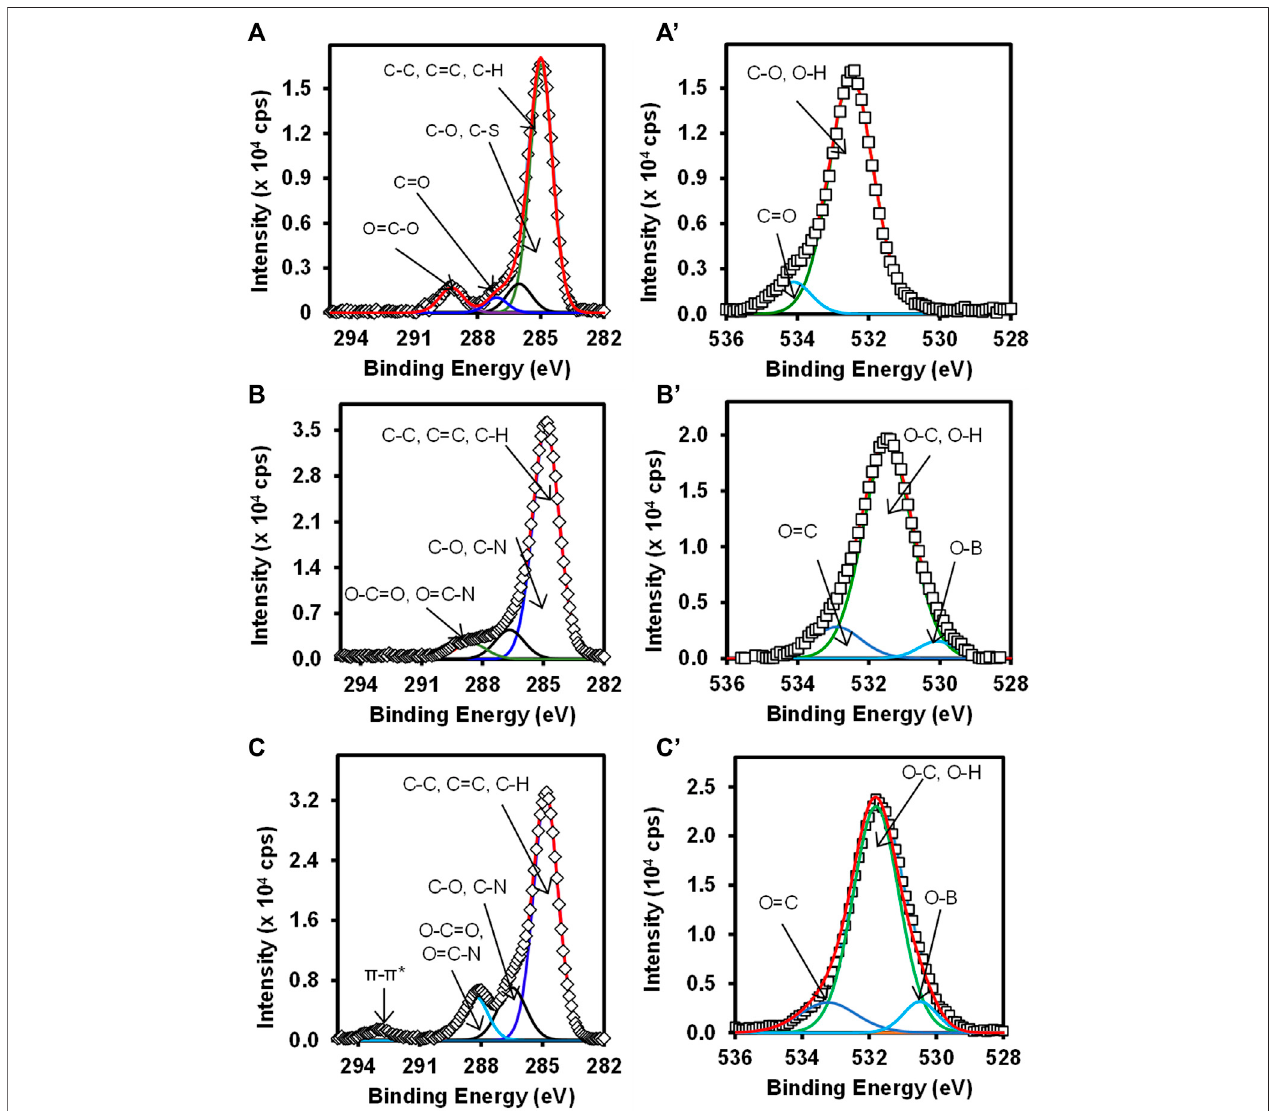
FIGURE 3 | High-resolution spectra of C 1s (A) Au-MBA SAM, (B) Au-MBA-APBA SAM, and (C) Au-MBA-APBA-mAb/glucose and O 1s (A ’ ) Au-MBA SAM, (B ’ ) Au-MBA-APBA SAM, and (C ’ ) Au-MBA-APBA-mAb/glucose.